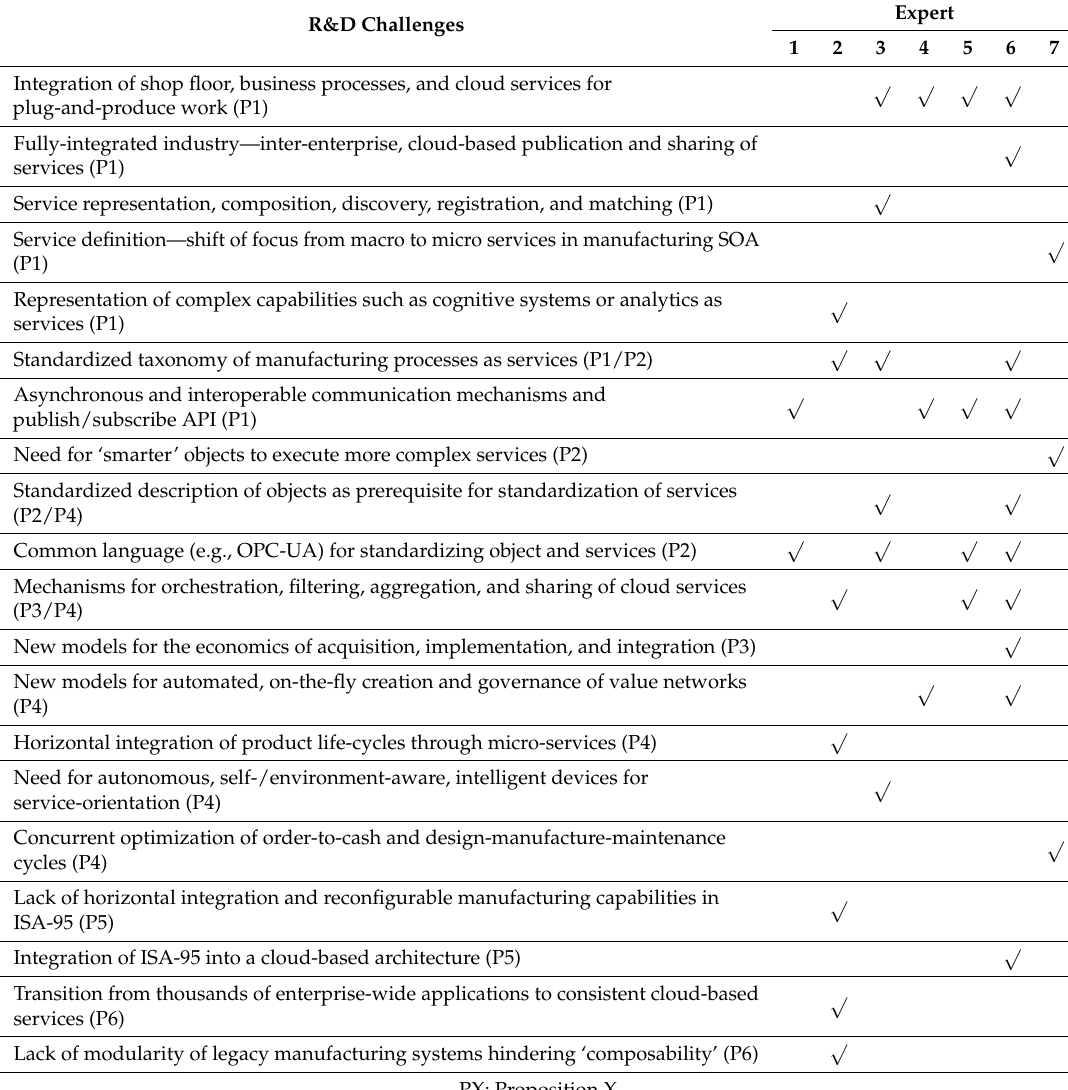
Table 1. Summary of R&D Challenges Identified by the Experts. Adopted from [4]. R&D